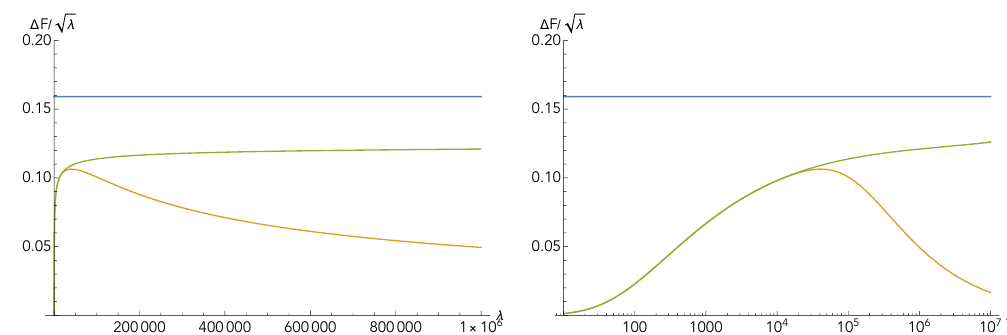
√ Figure 4 . Extrapolations of ∆ F/ λ (plotted here as functions of λ , not ˜ λ ) compared to the asymptotic value c 1 = 1 (blue line). In the left plot, in linear scale, the orange line is the diagonal 2 π Padé approximant based on 150 terms of the full weak-coupling expansion, i.e. the extension of (3.4) to the order λ 150 . This Padé approximant breaks down shortly after λ = 10 4 . The green line is the Padé conformal result and it extends to much higher values of the coupling λ . The left plot √ strongly supports the functional form ∆ F ∼ λ at large λ . The convergence of the coefficient to the asymptotic value is steady but slow, as illustrated in the right panel on a logarithmic scale. See section 6.2 for a more refined estimate of the overall